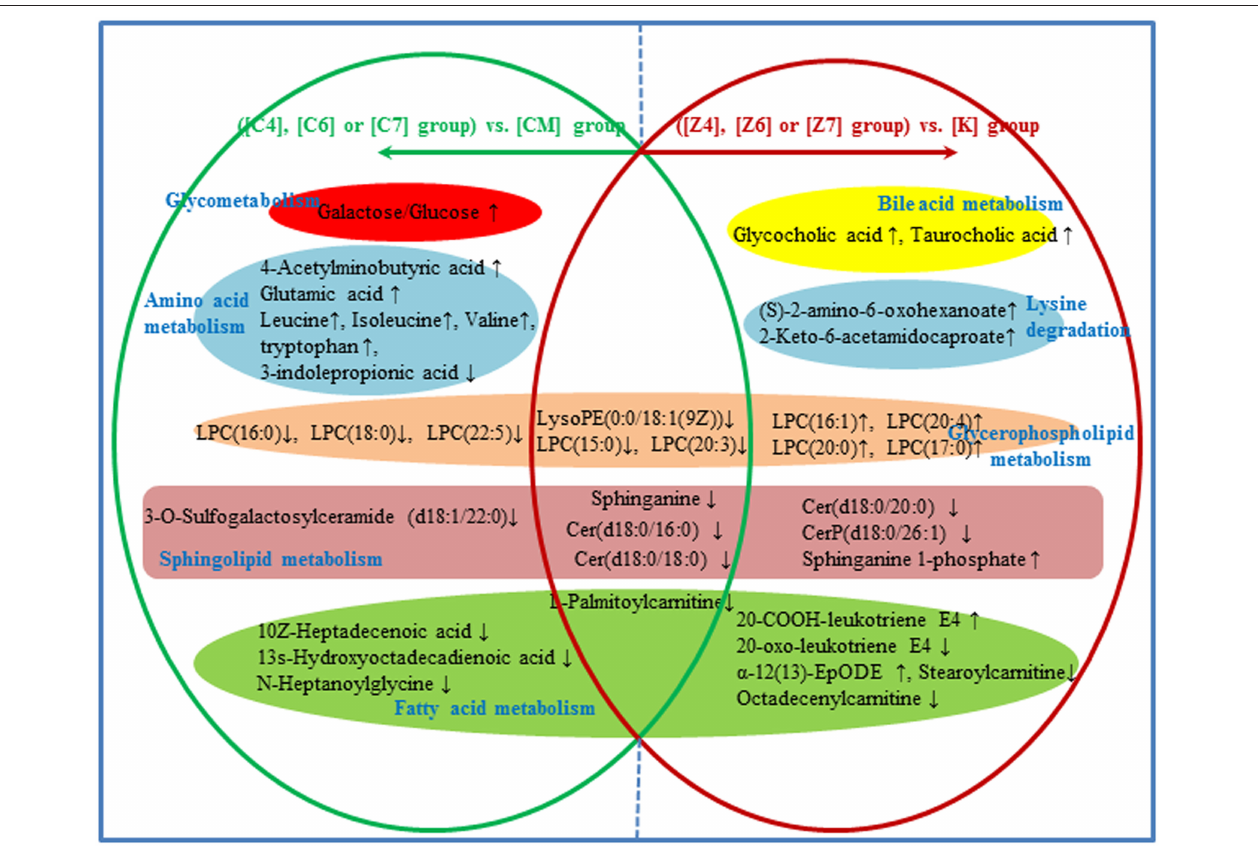
FIGURE 10 | Different metabolites and corresponding pathways in CUMS rats or healthy rats following PBR administration. “ ↑ ” and “ ↓ ” represent that the metabolite is up- or down-regulated in CUMS rats or healthy rats folloowing PBR administration. In CUMS rats following PBR administration ([C4], [C6], and [C7]), glycometabolism and amino acid metabolism were up-regulated; however, glycerophospholipid metabolism, sphingolipid metabolism and fatty acid metabolism were down-regulated, all being compared with the corresponding group without drug treatment [CM]. In healthy rats following PBR administration ([Z4], [Z6], and [Z7]), lysine degradation and bile acid metabolism were up-regulated; however, the other three pathways of glycerophospholipid metabolism, sphingolipid metabolism and fatty acid metabolism were up- or down-regulated, all being compared with the corresponding group without drug treatment